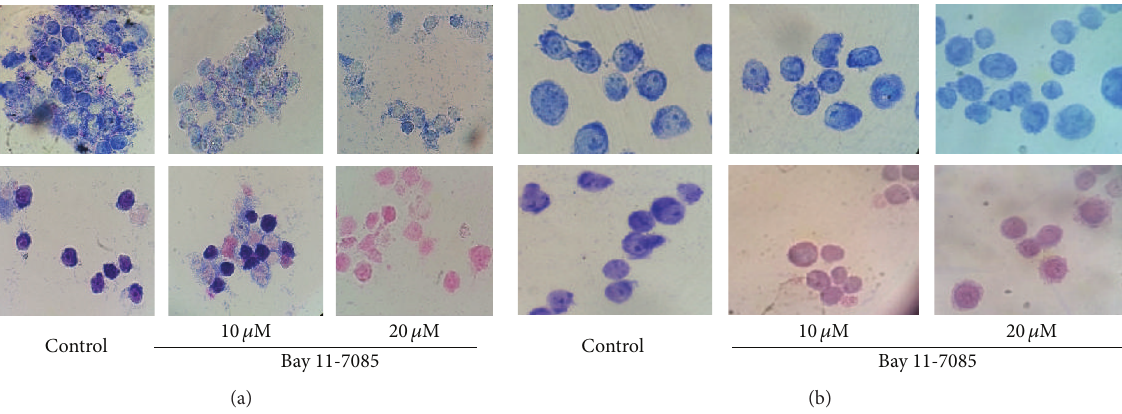
Figure 4: Bay 11-7085 induces apoptosis in TF-1 but not in MV4-11 cells. Log-phase TF-1 (a) and MV4-11 (b) cells were treated with Bay 11-7085 for 24 hours, after which the cells were collected and slides were prepared and stained following the protocol described in Section 2. Top panel: Giemsa staining ( × 1000); bottom panel: methylene blue/eosin staining ( ×